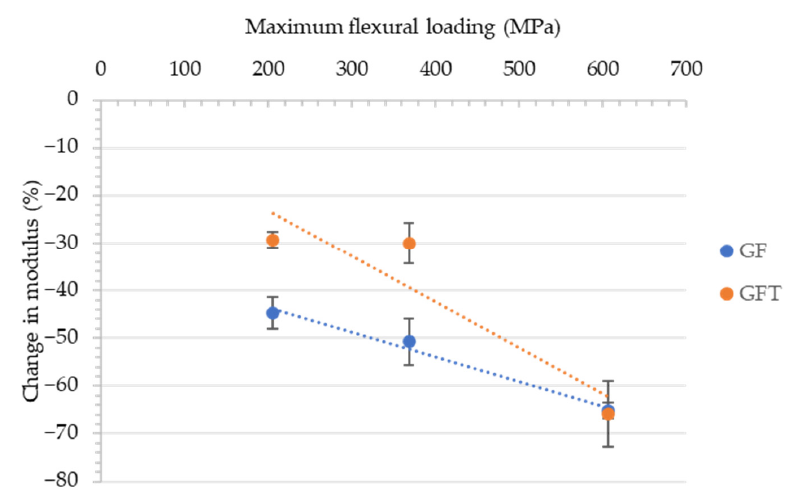
Figure 13. Glass fibre samples tested under cyclic loading at 50%, 70%, and 90% of their maximum loading. For GF the maximum flexural strength for each percentage was 260, 360, and 600 MPa, respectively.